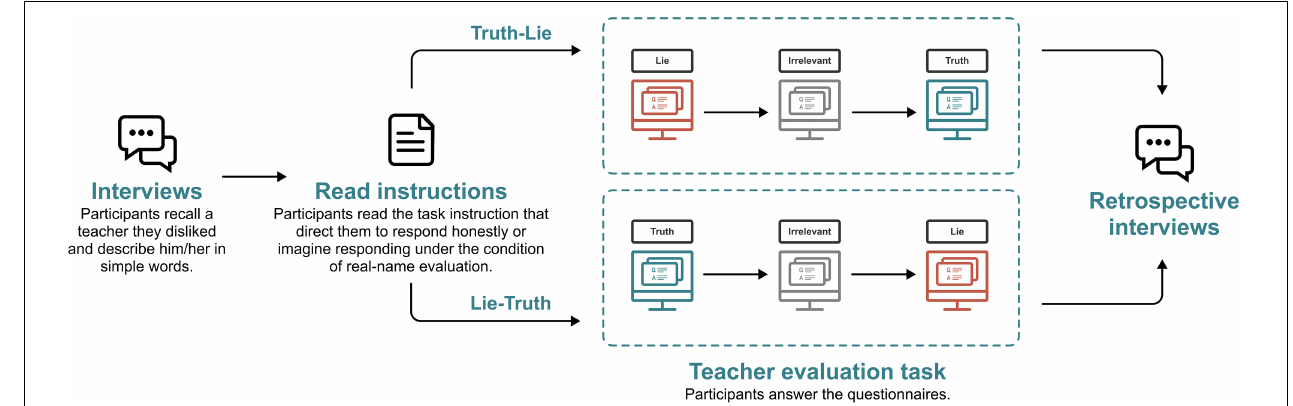
FIGURE 2 | The experiment procedure of Study